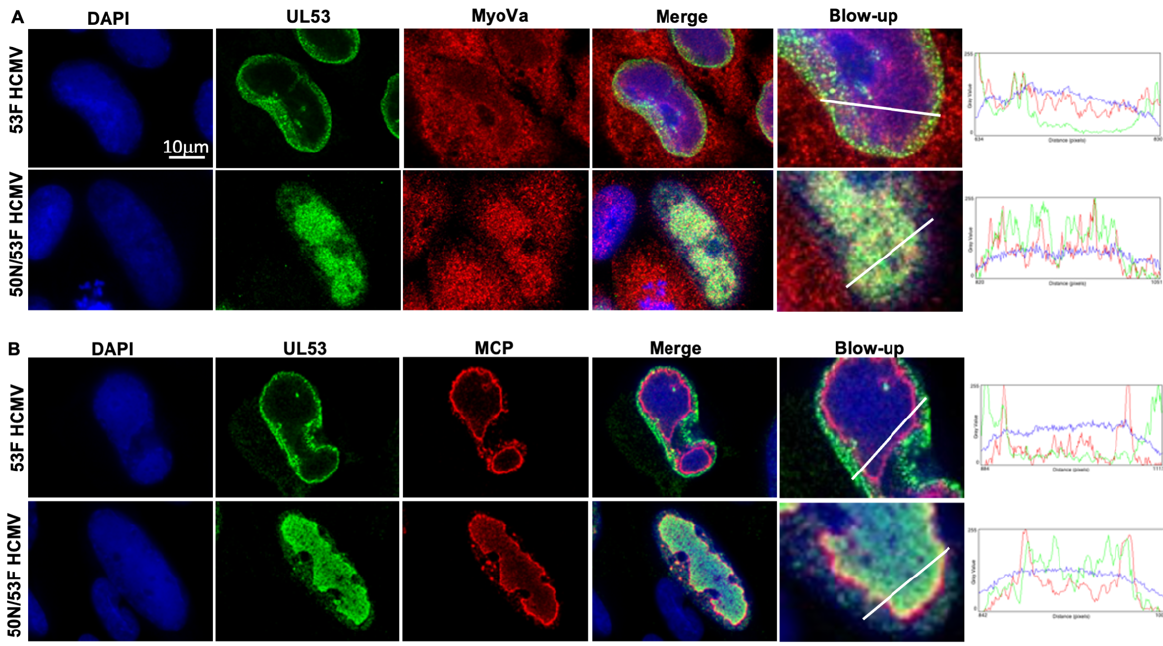
Figure 5. HFFs were infected with 53-F or 50N/53-F HCMV (MOI 1) and fixed at 72 hpi. Cells were then stained with DAPI (blue), α -FLAG (green), and in ( A ) α -myoVa (red) antibodies, or in ( B ) α - MCP (red) antibodies, and imaged with spinning-disk confocal microscopy. Yellow color indicates colocalization of UL53 with myoVa or MCP. Colocalization was measured by plotting fluorescence intensity of each channel across the indicated white lines. Images are single optical sections.